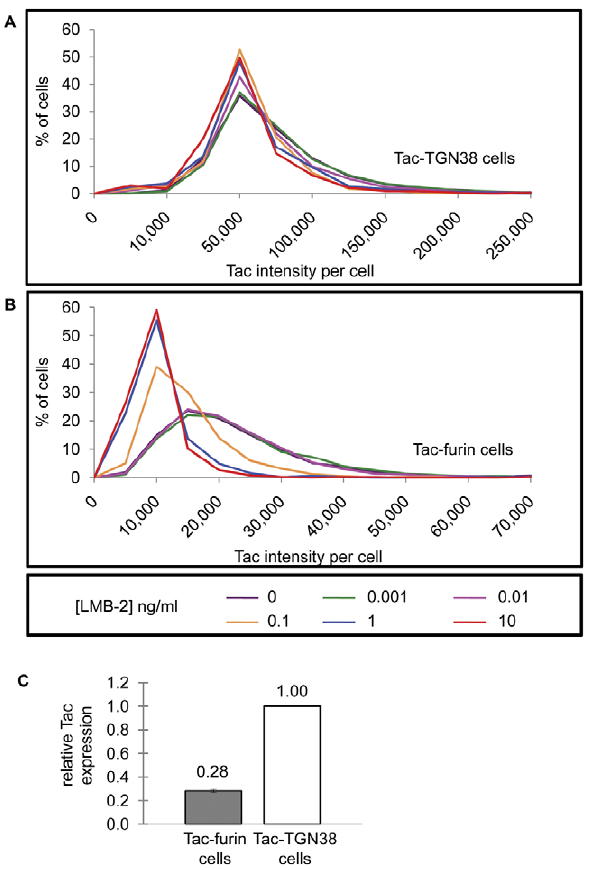
Figure 3. Effects of heterogeneous Tac expression on LMB-2 cytotoxicity. Tac-TGN38 ( A ) and Tac-furin ( B ) cells were treated for 24 hours with doses of LMB-2 up to 10 ng/ml. Cells were then fixed, permeabilized and stained with anti-Tac monoclonal antibody and Alexa546 conjugated secondary antibody. The histograms show the frequency distribution of Tac intensity for each cell line after exposure to varying concentrations of LMB-2. The experiments were replicated at least 3 times for each cell line, and representative data from one experiment are shown. C ) Tac-TGN38 and Tac-furin cells were fixed and then stained with Hoechst dye, anti-Tac monoclonal antibody and subsequently with Alexa546 conjugated secondary antibody. The average fluorescence per cell was measured as described in Methods. Images were subjected to background and shade correction before intensity calculations. Fluorescence intensity per field was divided by the cell number to calculate the average intensity per cell. The data are the average of 9 experiments. The standard error of the mean is